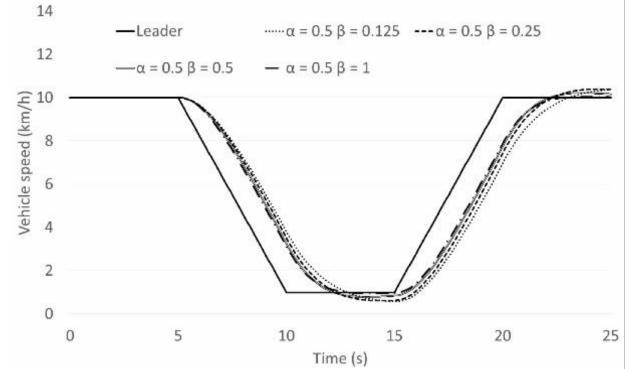
Figure 3. The following vehicle’s speed behaviour ( β is